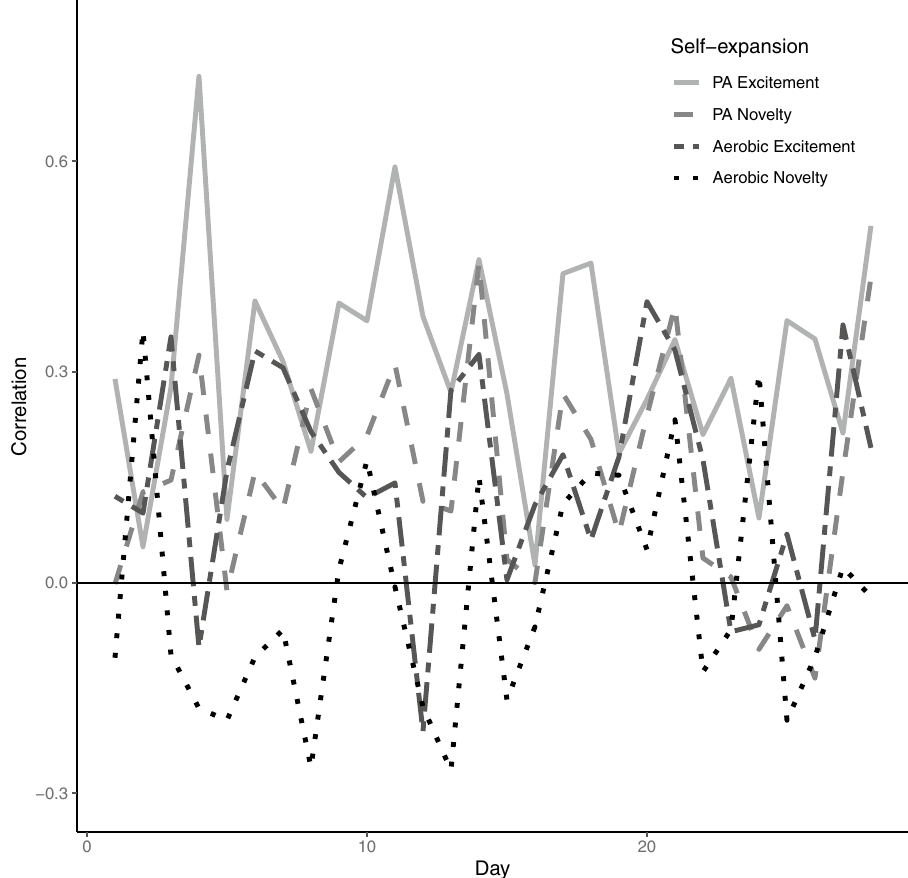
Figure 2. Daily correlations between daily steps and physical activity self-expansion variables (solid light gray is physical activity self-expansion excitement, dashed gray is physical activity self-expansion novelty, double-dash dark gray is aerobic excitement and dot-dash black is aerobic novelty).